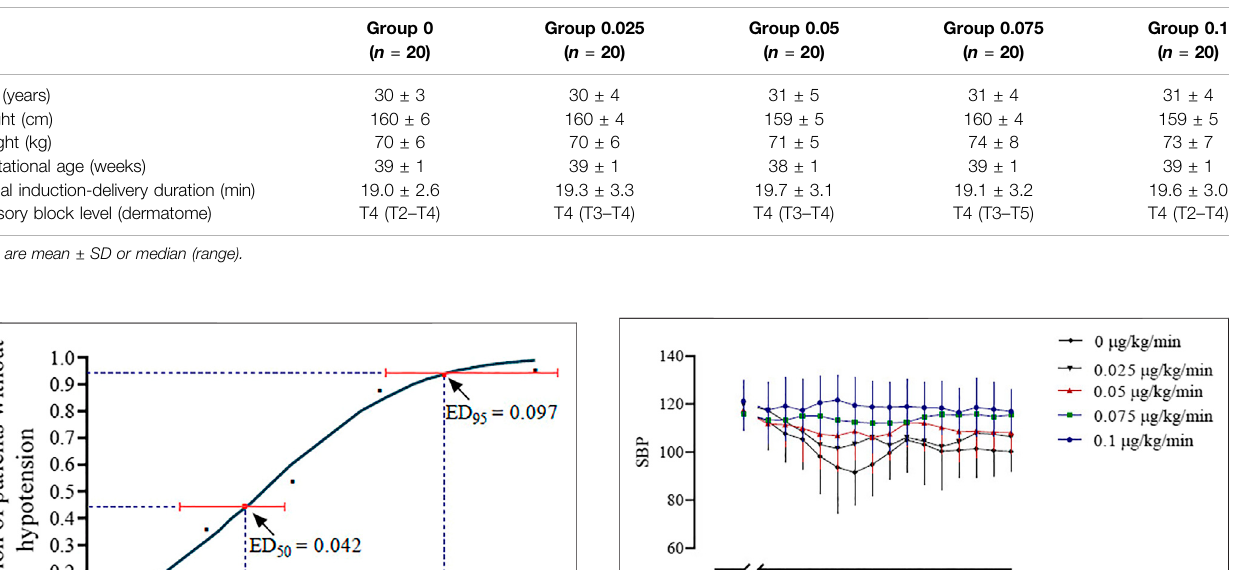
TABLE 1 | Demographic data, surgical times and sensory block level.